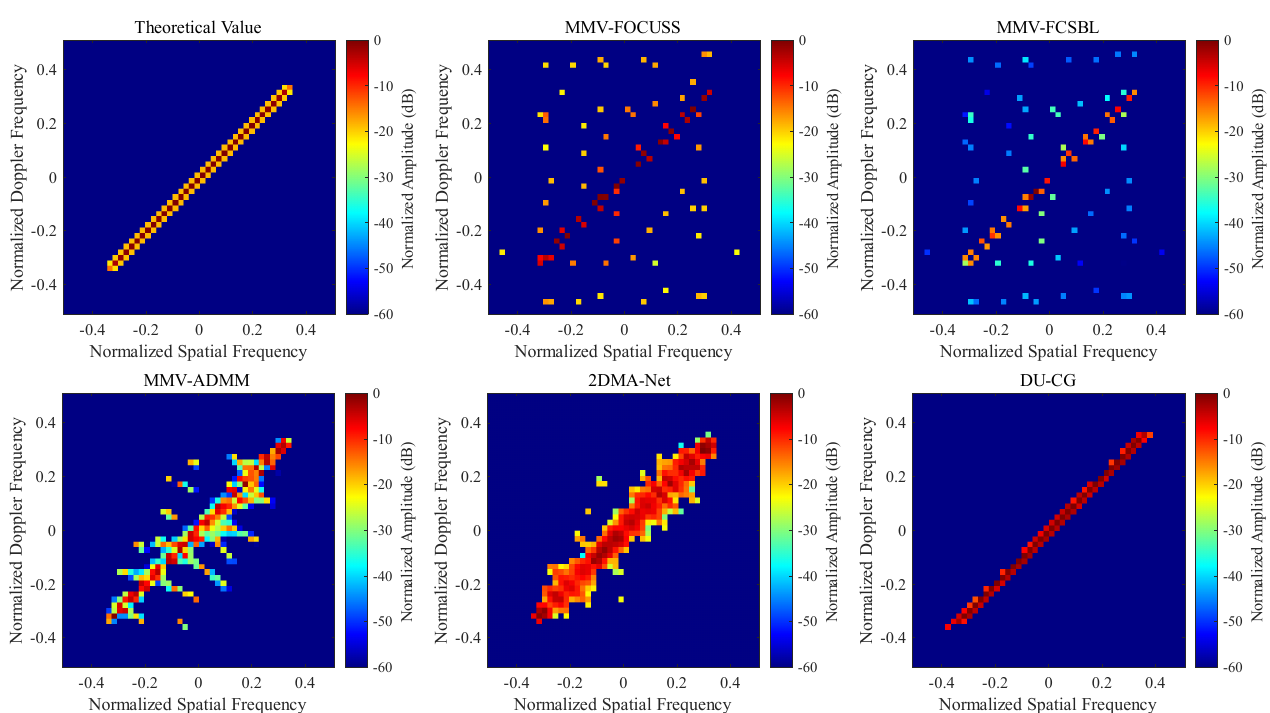
Figure 11. Clutter spectrum estimation results obtained using different methods in the non-ideal case with the ICM as 0.5 m/s.